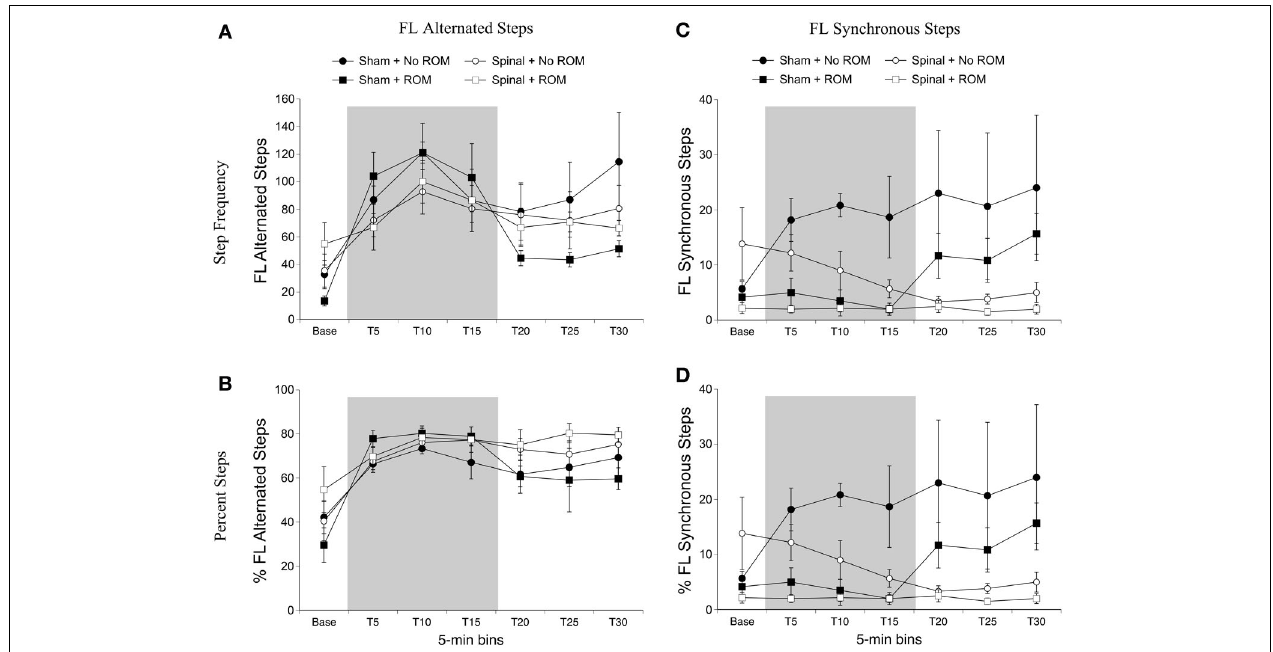
FIGURE 3 | Step frequency and percentage of forelimb steps for sham and spinal P10 rats by ROM condition. Frequency (A) and percentage (B) of alternated forelimb steps, and frequency (C) and